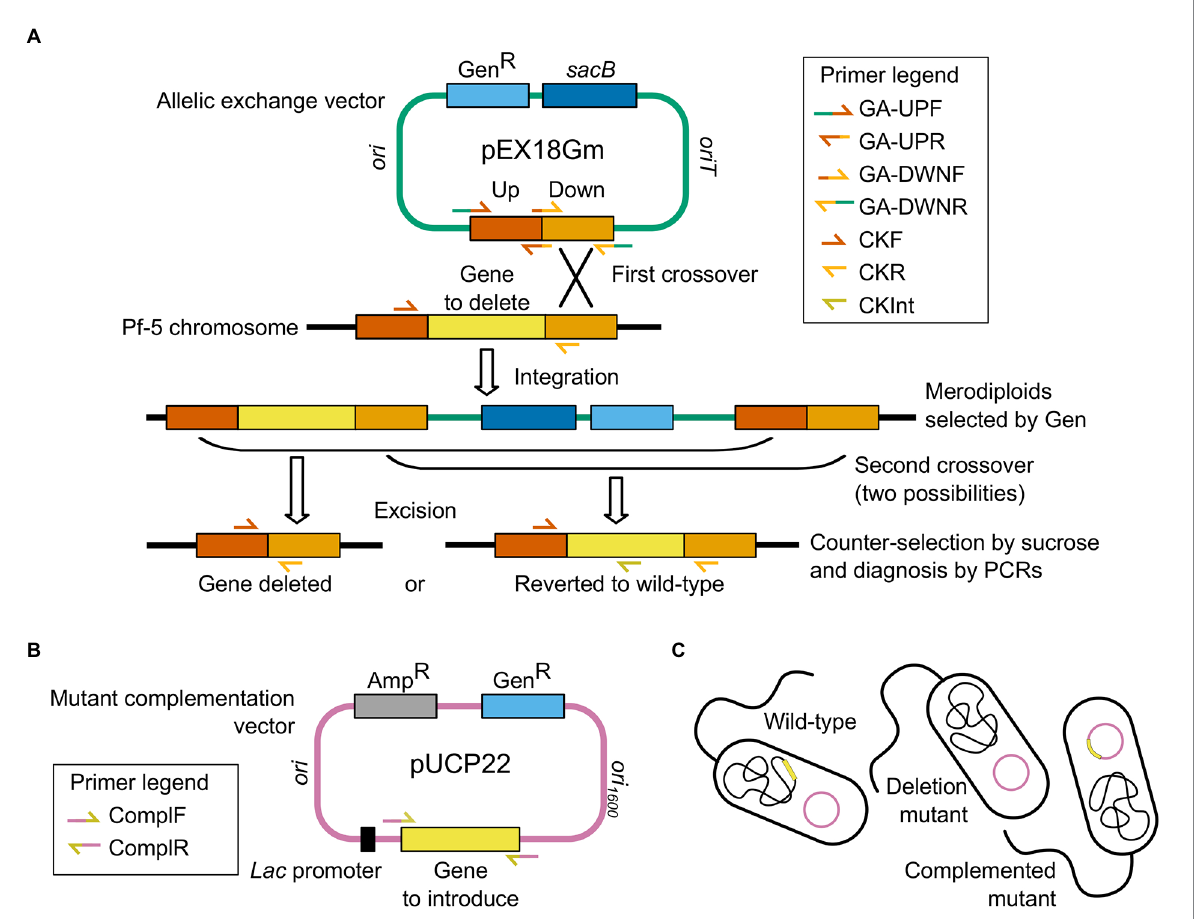
FIGURE 1 Generation of Pseudomonas protegens Pf-5 knockout mutants and complemented mutants by two-step allelic exchange and plasmid-based complementation. (A) Construction of the allelic exchange vector for in-frame deletion of phlA or pltD (yellow) in the bacterial wild-type genome. The gene knockout cassette comprises the DNA sequences immediately upstream and downstream of the gene to be deleted (Up and Down flanks, red and orange) and is assembled into the suicide vector pEX18Gm (green) carrying the gentamicin resistance (Gen R , light blue) and sucrose sensitivity ( sacB , dark blue) genes. Integration of the allelic exchange vector in Pf-5 chromosome occurs by homologous recombination (first crossover) after bacterial conjugation, and merodiploids are selected on gentamicin-amended media. Subsequent homologous recombination (second crossover) results in the loss of the allelic exchange vector backbone, which is selected with sucrose-amended media. Depending on the second crossover locus, vector excision either restores the wild-type allele or deletes the gene in the bacterial chromosome. Clones with the correct genotype (gene deleted) are discriminated from reverted clones by diagnostic PCRs. (B) Construction of the complementation vector for electroporation into complemented mutants, resulting in plasmid-based complementation of phlA or pltD (yellow). The gene (yellow) is assembled into the multicopy shuttle vector pUCP22 (pink), under transcriptional control of a constitutive lac promoter (black), which carries the gentamicin resistance (Gen R , light blue) and ampicillin resistance (Amp R , gray) genes. (C) The empty complementation vector (pink plasmid) is introduced into the wild-type bacteria (undisturbed chromosome in black with target gene in yellow) and the deletion mutants (knockout chromosome in black missing target gene), while the recombinant complementation vector (pink plasmid carrying target gene in yellow) is introduced into the complemented mutants (knockout chromosome in black missing target gene). Combined steps thus result in unscarred mutants that differ from the wild-type strain only in the presence or absence of the targeted gene (yellow). Primers used to monitor each key step are indicated in the corresponding legends. Drawings are not to